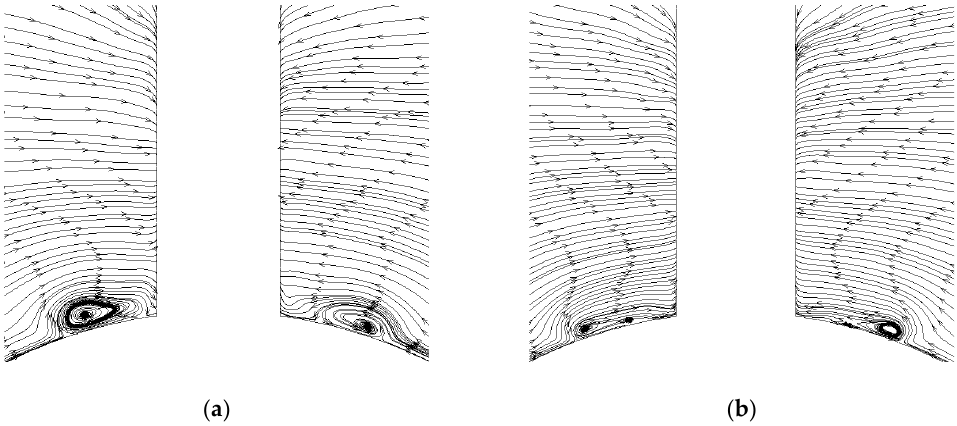
Figure 20. The streamline of Plane C between the original model and the model with triangular VGs. ( a ) The original model; ( b ) the VGs at 0.1c. ( a ) The original model; ( b ) the VGs at